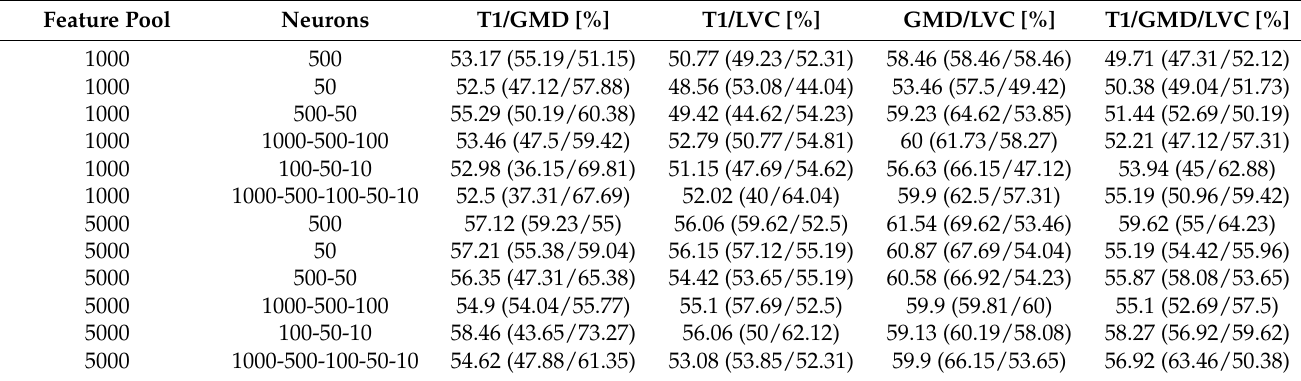
Table 3. Results for SAE learned on all combinations of the three types of features (T1, GMD, and LVC). The metrics listed represent the accuracy (sensitivity/specificity) in